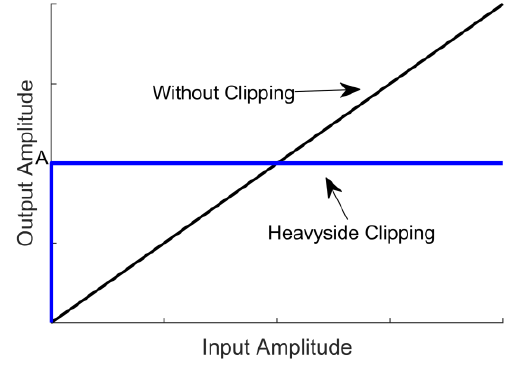
Figure 5. Heavyside Clipping function.